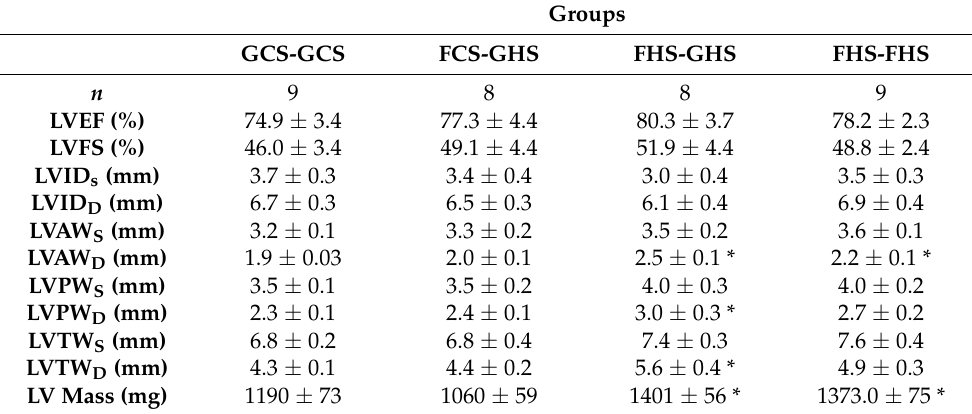
Table 4. Echocardiographic Parameters at the End of Phase III.